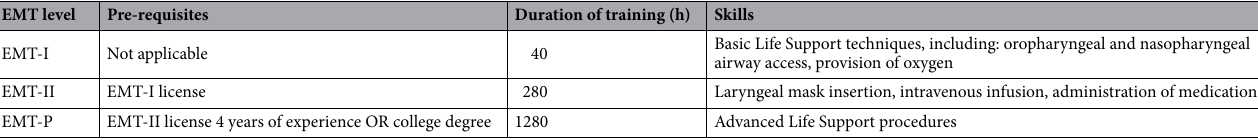
Table 1. EMT certification requirements. EMTs emergency medical